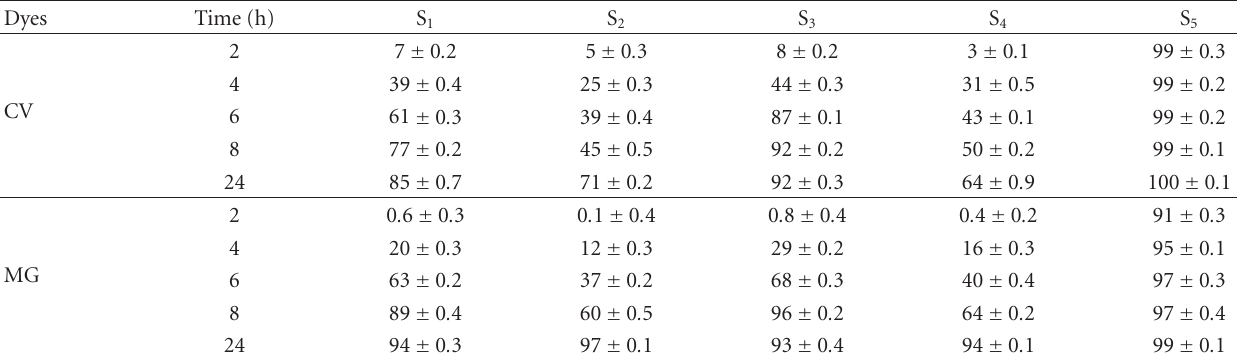
Table 1: Decolorization of dyes by individual pure culture of isolated bacterial strain and by a bacterial consortium. Dyes